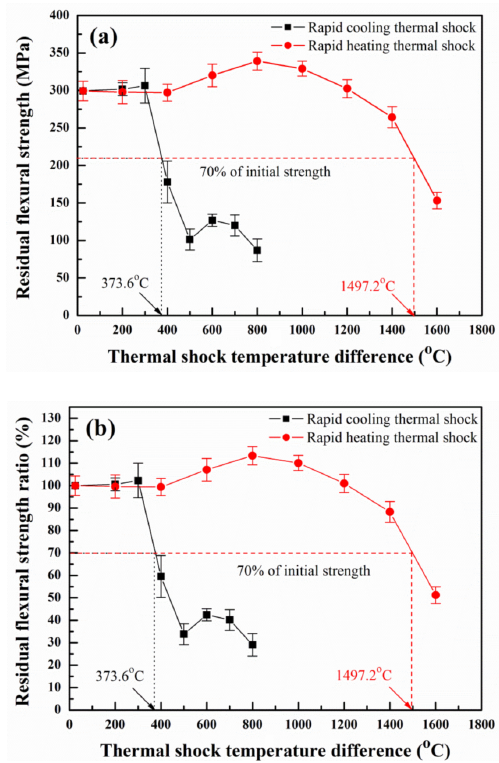
Fig. 3 (a) Residual flexural strength and (b) residual flexural strength ratio of ZrB 2 –SiC ceramic after rapid cooling and rapid heating thermal